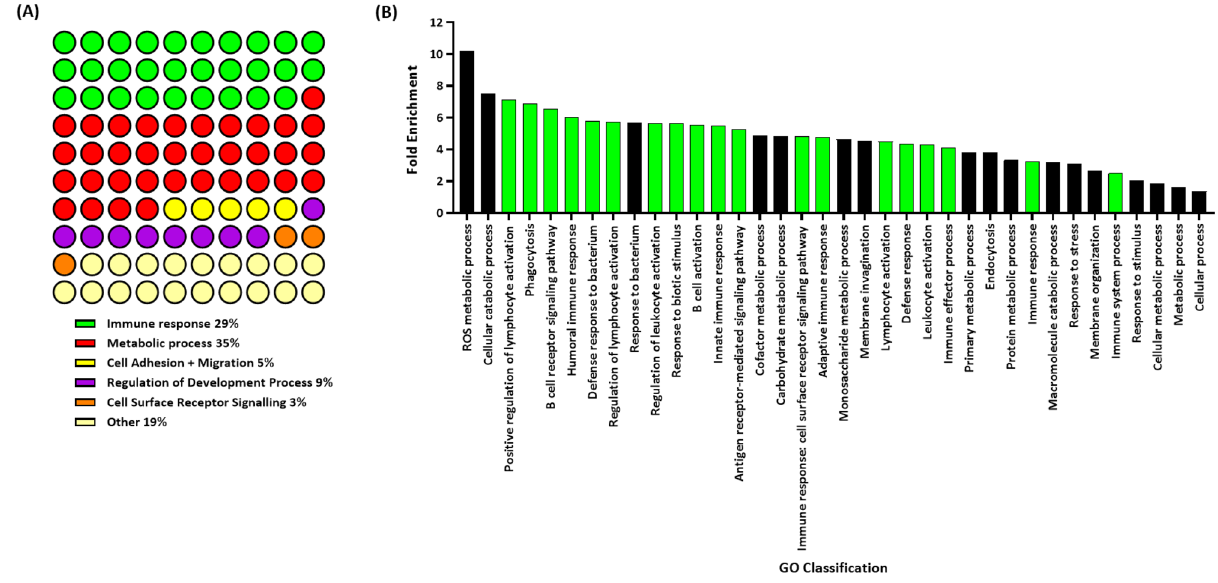
Figure 2. Characterisation of the significantly upregulated proteins. ( a ) ClueGo analysis of the biological processes of the significantly up regulated proteins. ( b ) PANTHER analysis of the 377 significantly upregulated proteins demonstrating significant overrepresentation of proteins belonging to the immune response (green bars) in mastocytosis patients.